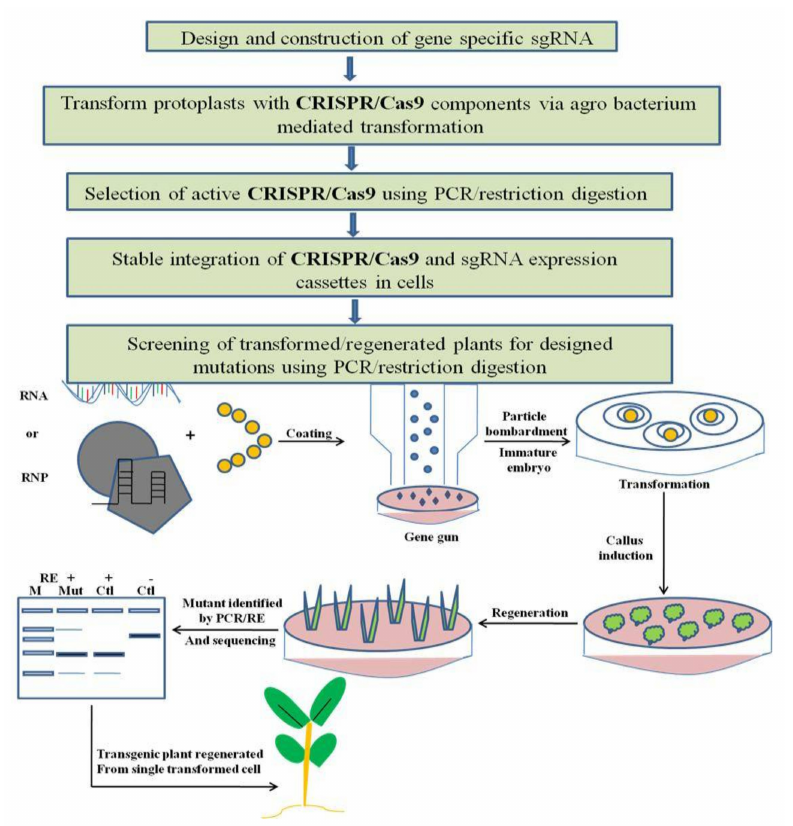
Figure 3. Working principle of CRISPR/Cas9 based genome editing in plants. Plant genome editing can typically be divided into four continuous steps, and the estimated time needed for each step is indicated. PCR/RE, polymerase chain reaction/restriction enzyme digestion. The CRISPR–Cas9 RNAs (in vitro synthesized Cas9 and sgRNA transcripts) or pre-assembled CRISPR–Cas9 RNP can be delivered into immature embryos via particle bombardment. Alternatively, pre-assembled CRISPR– Cas9 RNP can be transfected into plant protoplasts. Bombarded/transfected cells are induced to form calli, from which seedlings are regenerated under the selection-free conditions. Regenerated plants are screened for mutation via the PCR/RE assay and sequencing. Delivering CRISPR–Cas9 reagents via RNP limits their temporal activity, thereby improving their precision. RE, restriction enzyme; M, DNA marker; mut, mutant; ctrl,